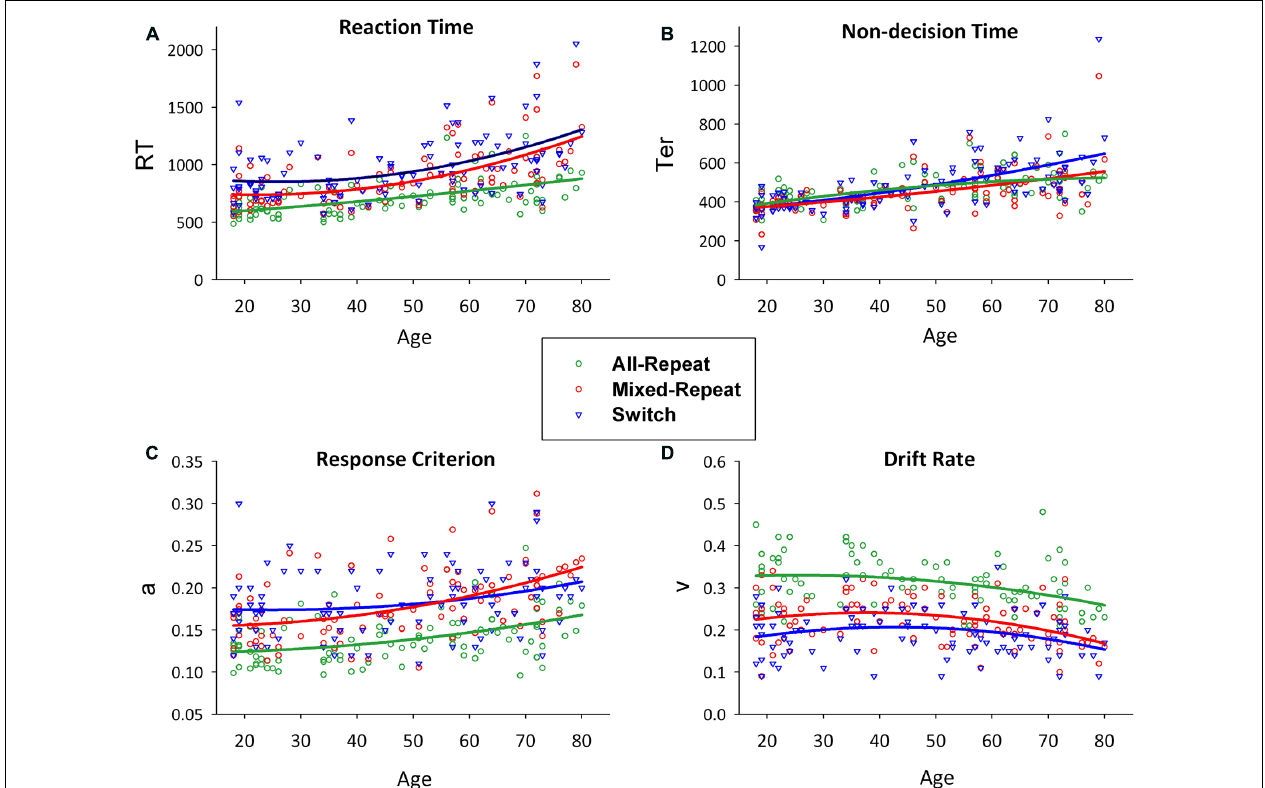
FIGURE 2 | Scatterplots of age against reaction time (A) and model parameters (non-decision time [B], response criterion [C] and drift rate [D]) for all-repeat (green), mixed-repeat (red) and switch (blue) trials. Mixing cost is shown as the difference between green and red lines, and switch cost as the difference between red and blue lines. Adapted from (Karayanidis etal.,